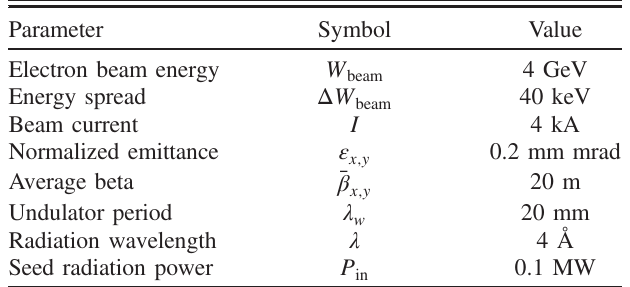
TABLE I. Main parameters of the MAX IV FEL case used in our simulation